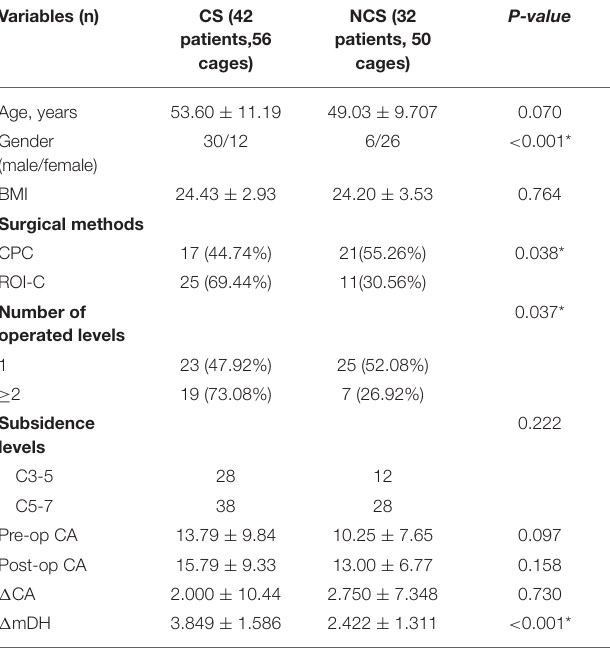
TABLE 4 | Univariate analysis of clinical and radiological factors between groups.